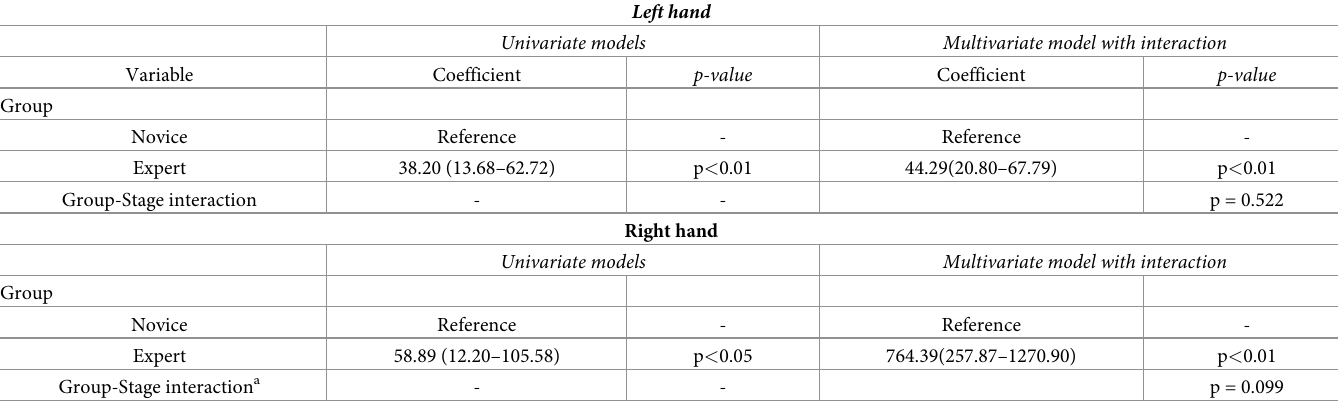
Table 2. Univariate and multivariate linear analysis to determine differences in speed by group, and its interaction with stage, for both